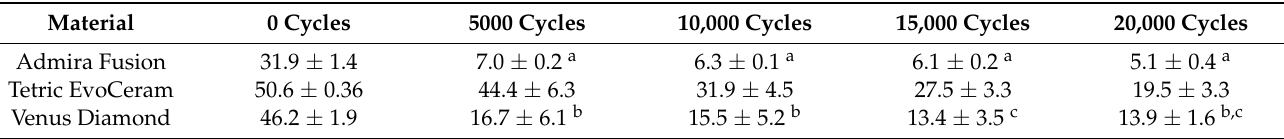
Table 3. Mean gloss values and standard deviations for the tested materials after different numbers of toothbrushing cycles.